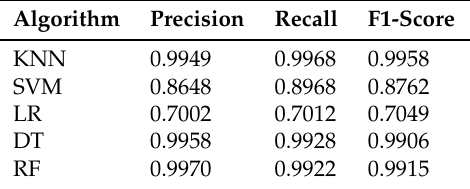
Table 6. Unbalanced CIDDS-001 scores.